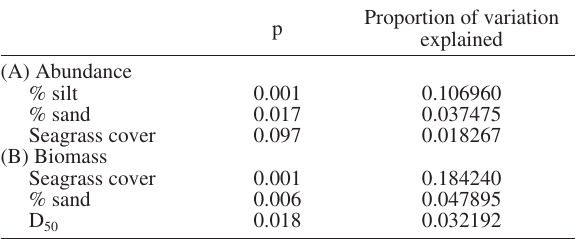
Table 5. – Results of the univariate multiple regressions tests (se- quential test) testing for significant relationships between predictor variables and the total (A) abundance and (B) biomass of the pearly razorfish, Xyrichtys novacula , recorded through the SNs. p